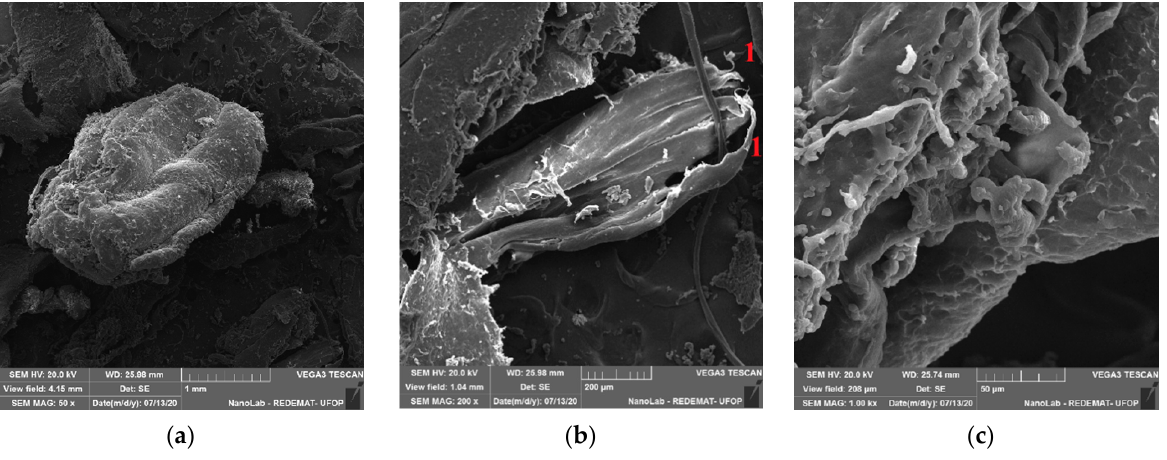
Figure 5. SEM images of waste PE at 50× ( a ), 200× ( b ), and 1000× ( c ) magnifications.